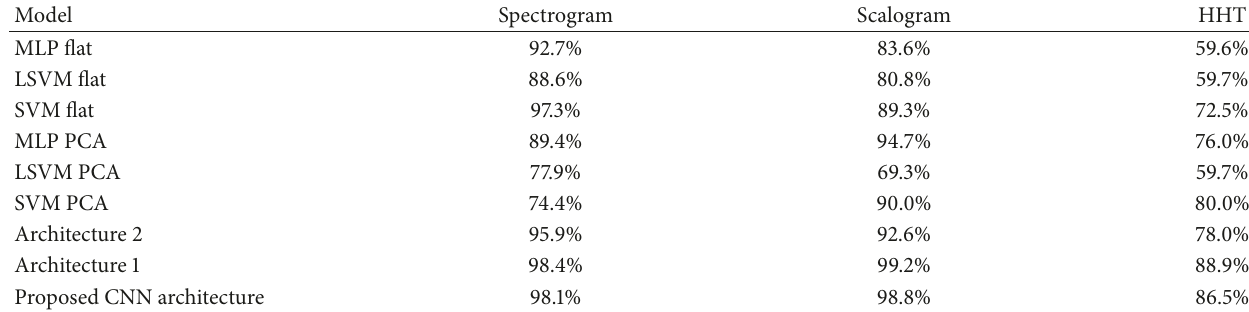
Table 18: Prediction accuracies for 32 × 32 image